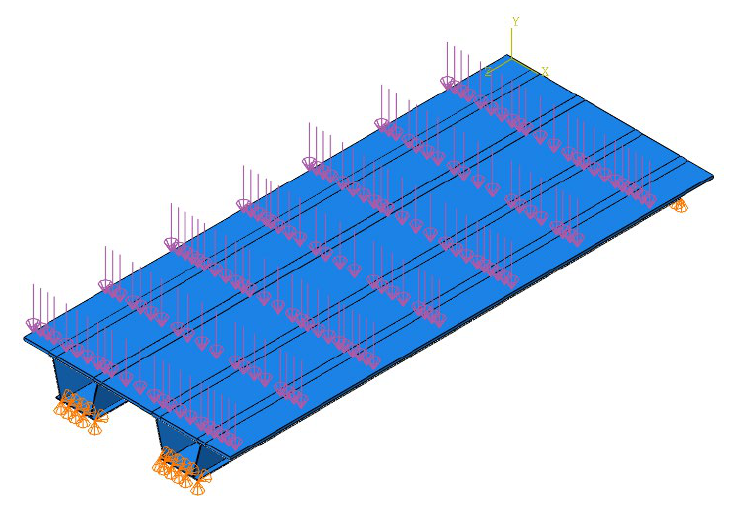
Figure 6. Application of loading